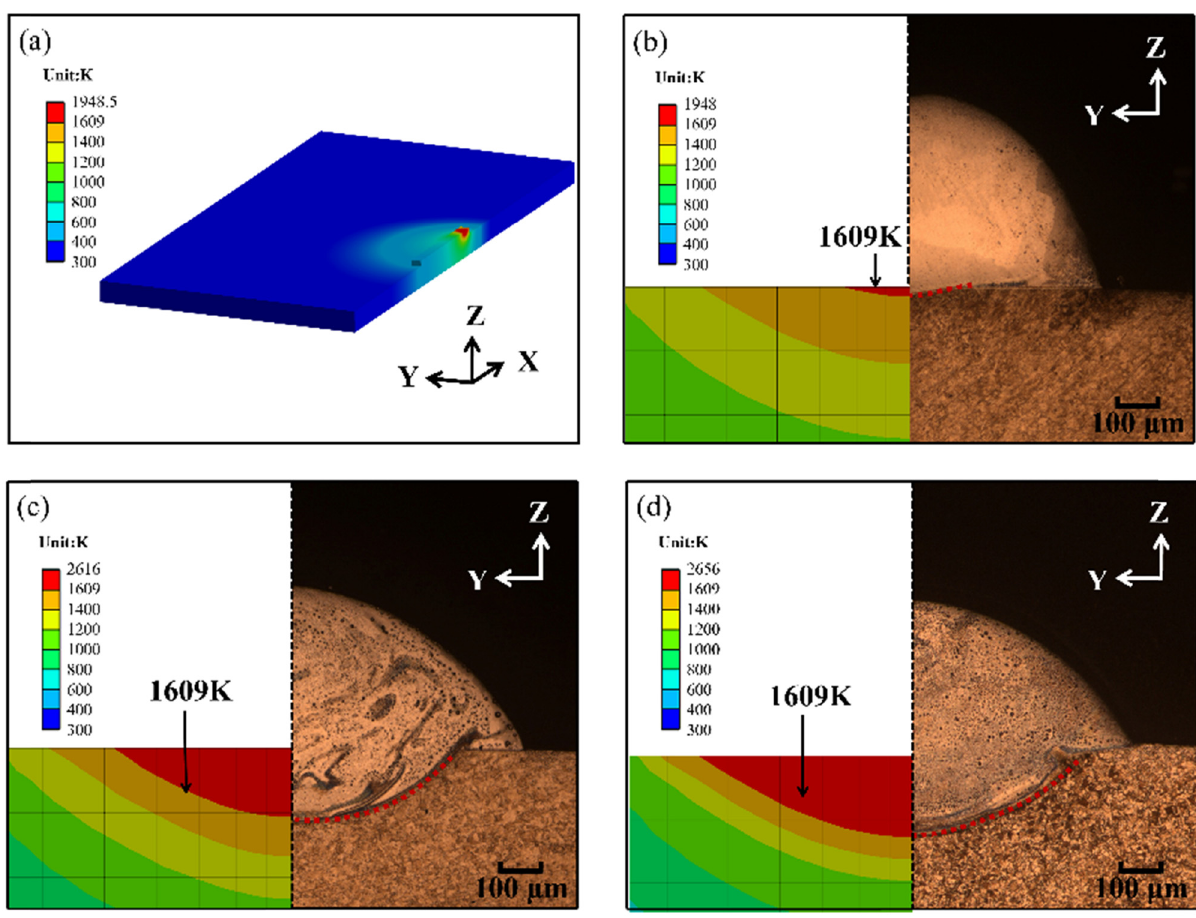
Figure 10: Finite element numerical simulation group diagram ( a ) sample 1 temperature distribution diagram. ( b – d ) Sample 1, sample 2, and sample 3 molten pool contrast